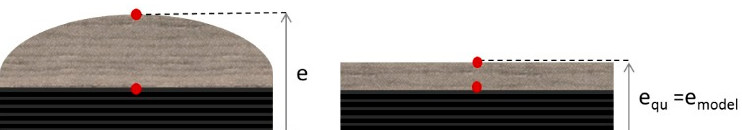
Figure 10. Scheme of the determination of the equivalent thermal conductivity with a volume constant assumption [6].